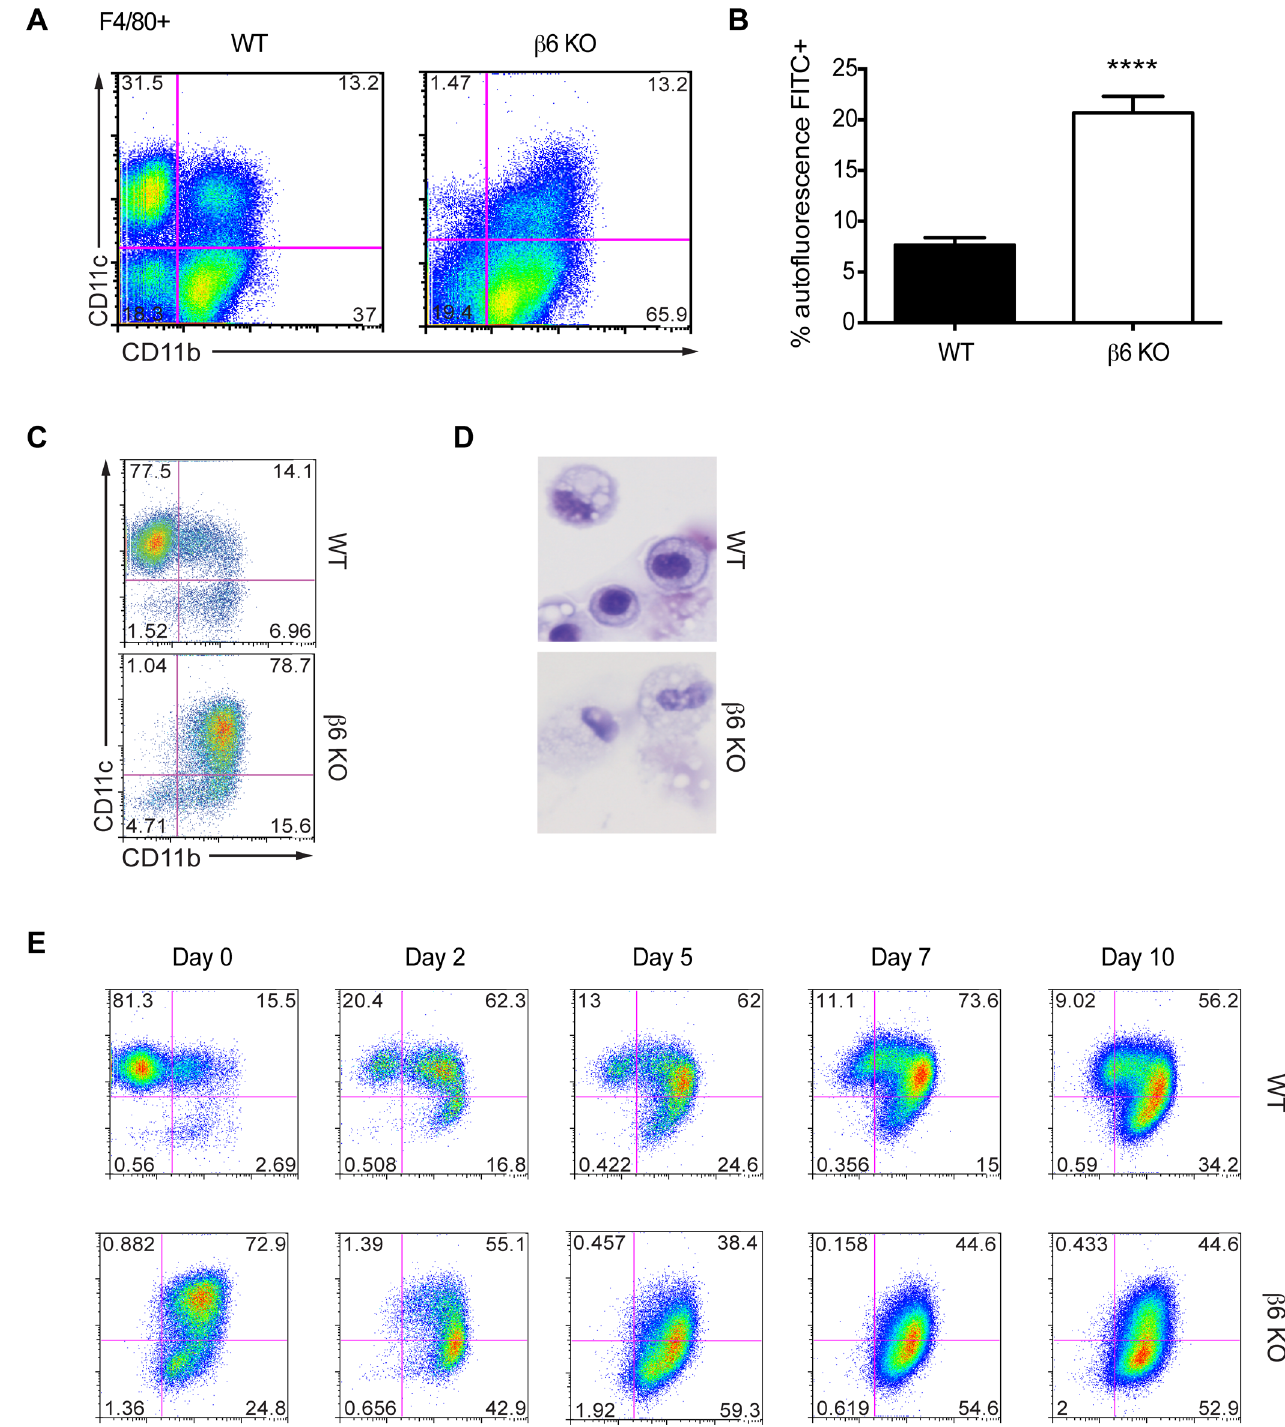
Fig 5. Altered alveolar macrophage phenotype in the lungs of β 6 KO mice. (A) Cells were isolated from the lungs of uninfected WT or β 6 KO mice and gated on F4/80 + cells then divided into macrophage and DC populations by CD11b and CD11c expression. (B) Quantification of the percentage of autofluorescent F4/80 + CD11c + CD11b + cells. p < 0.0001 by Student ’ s t test. (C) Macrophages were isolated from the lungs of uninfected WT (littermate controls) and β 6 KO mice using the gating strategy shown in S2A Fig. (D) Cytospin analysis was performed on sorted macrophages representing the dominant populations of WT or β 6 KO mice. (E) Macrophage populations were analyzed from the digested lungs of WT and β 6 KO mice at the indicated times post-influenza inoculation. Data is representative of two independent experiments, n = 3 – 5 mice per